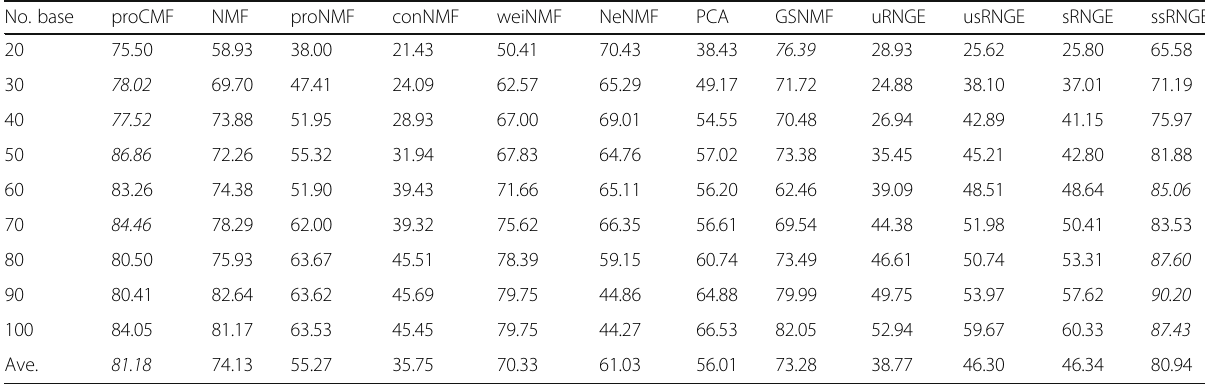
Table 7 Facial expression recognition rate (%) using the occluded CK+ with different subspace dimensionalities (case of occluded eyes) No. base